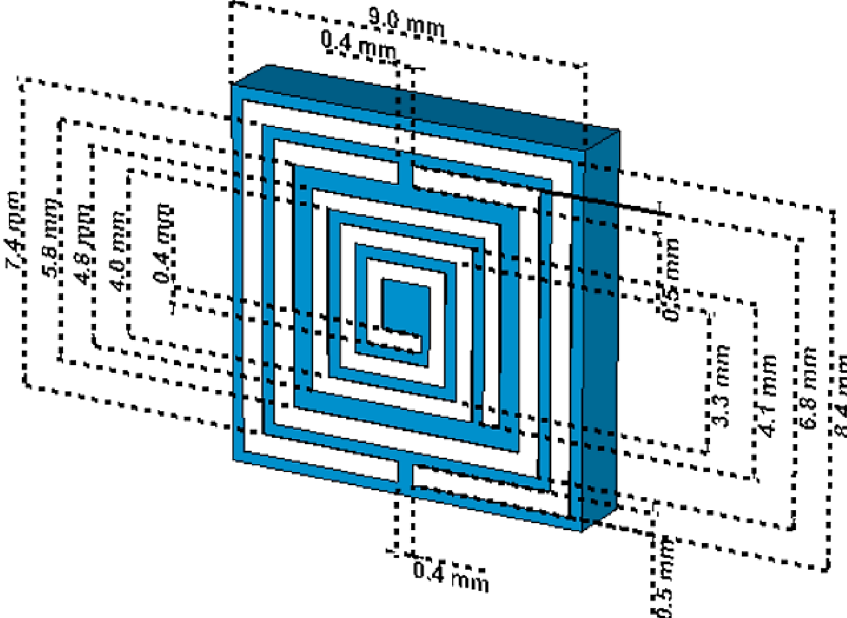
Figure 1. Proposed metamaterial unit cell with the dimensional